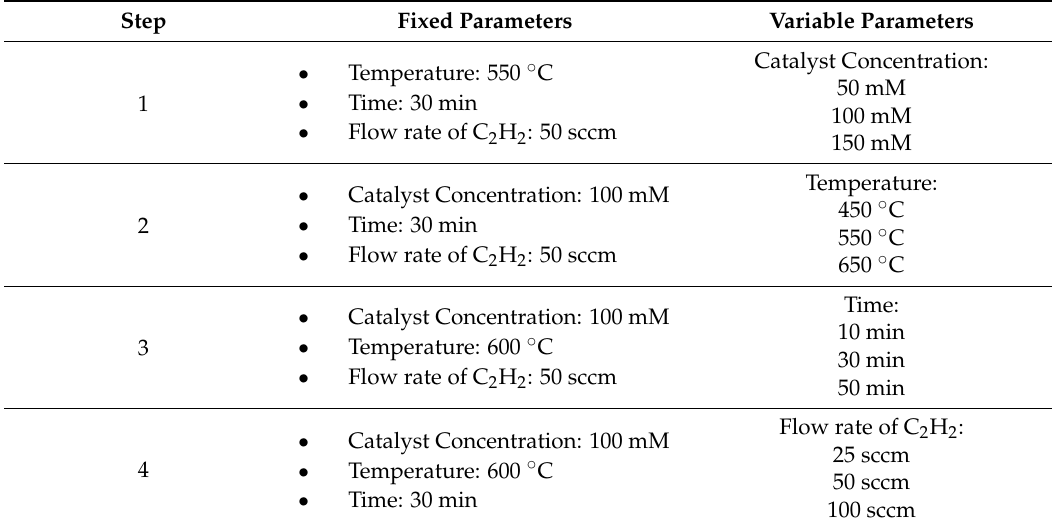
Table 6. Different operating conditions for different CNF